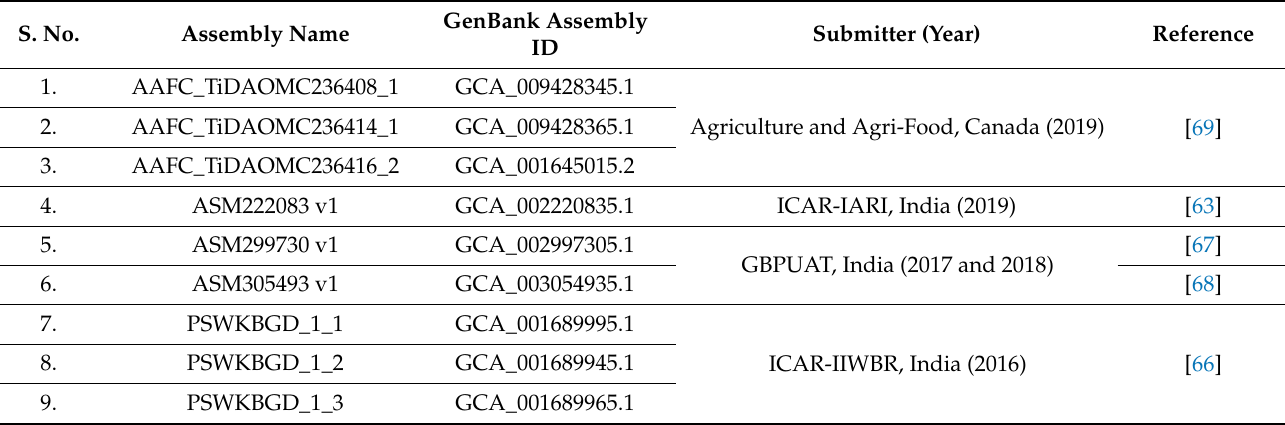
Table 2. List of genomes of Tilletia strains available till